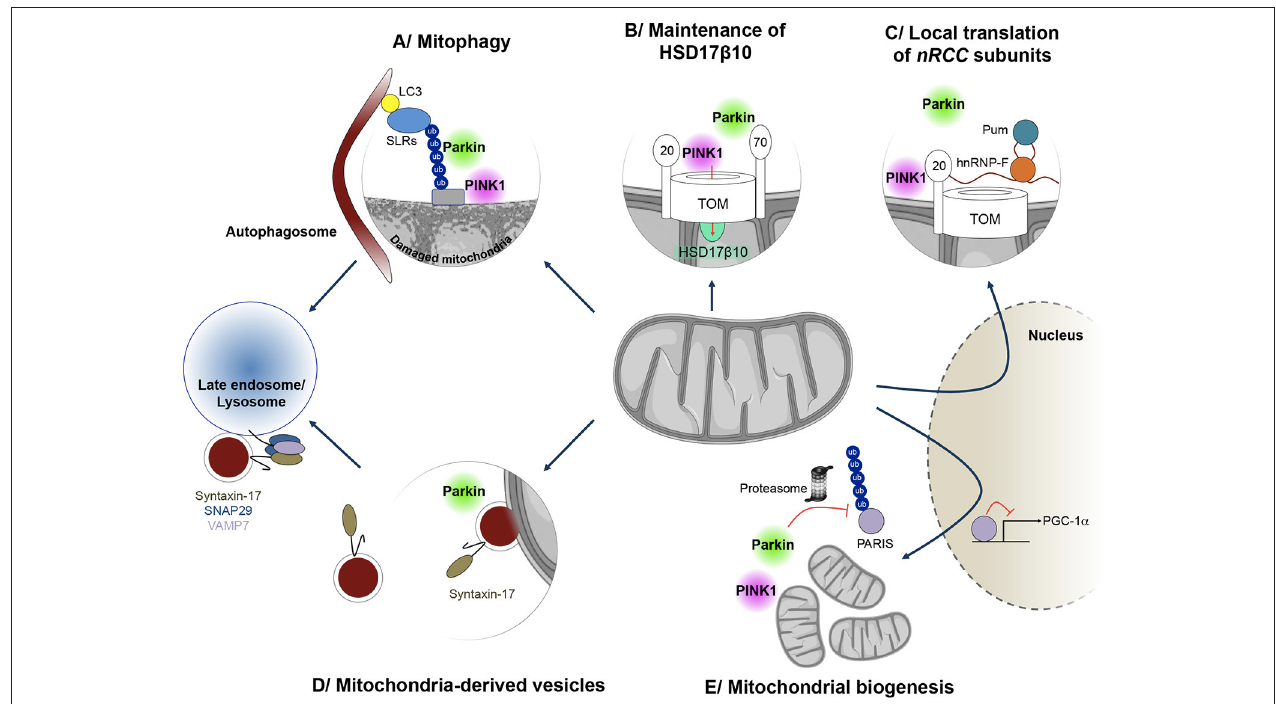
FIGURE 1 | Mitochondrial quality control mechanisms regulated by PINK1 and Parkin. PINK1 and Parkin have cooperative roles in several processes implicated in mitochondrial surveillance. (A) When mitochondria are damaged, Parkin is recruited to the mitochondrial surface and activated by PINK1, to exert its E3 ubiquitin protein ligase function. Ubiquitin chains on mitochondria are preferentially bound by sequestosome 1/p62-like autophagy receptors (SLRs), such as Optineurin and NDP52, which in turn mediate autophagosome formation on the damaged mitochondrion, leading to mitophagy. (B) Parkin is also involved in maintenance of mitochondrial levels of the multifunctional PD-linked mitochondrial enzyme HSD17B10, possibly by promoting its import through the TOM complex (C) PINK1 and Parkin can also control localized translation of several mRNAs for nuclear-encoded subunits of respiratory chain complexes (nRCC) . Translationally repressed nRCC mRNAs are localized in a PINK1/Tom20-dependent manner to the mitochondrial outer membrane, where they are derepressed by Parkin through ubiquitin-dependent displacement of translation repressors, including Pumilio and Glorund/hnRNP-F. (D) PINK1 and Parkin also control the formation of so-called mitochondria-derived vesicles (MDVs), leading to the specific degradation of oxidized or damaged mitochondrial content by late endosomes/lysosomes. In this process, Syntaxin-17 is recruited to MDVs during budding, forming a ternary SNARE complex at the late endosome, together with SNAP29 and VAMP7, to mediate fusion. (E) Parkin also regulates the process of mitochondrial biogenesis by promoting the proteasomal degradation of the PGC-1 α transcriptional repressor PARIS, in a PINK1-dependent